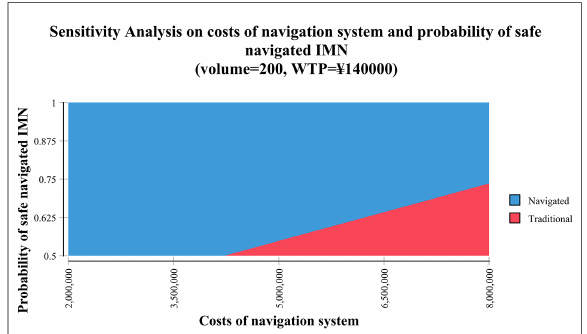
FIGURE 3 Two-way sensitivity analysis demonstrated the relationship between the cost of the navigation system and the probability of navigated intramedullary nailing (IMN) with the lag screw inside the safe zone. The blue area indicated the pro fi les for which the navigated IMN was more cost-effective (the cost was below the willingness- to-pay [WTP] threshold of ¥140,000 per quality-adjusted life-year [QALY]) in institutes with a volume of 200 cases per year. The red area indicated that the pro fi les for which the traditional IMN was more cost-effective in the same settings. CAOS: computer- assisted orthopaedic system; IV: Inverse variance method; CI: con fi dence intervals; df: degrees of